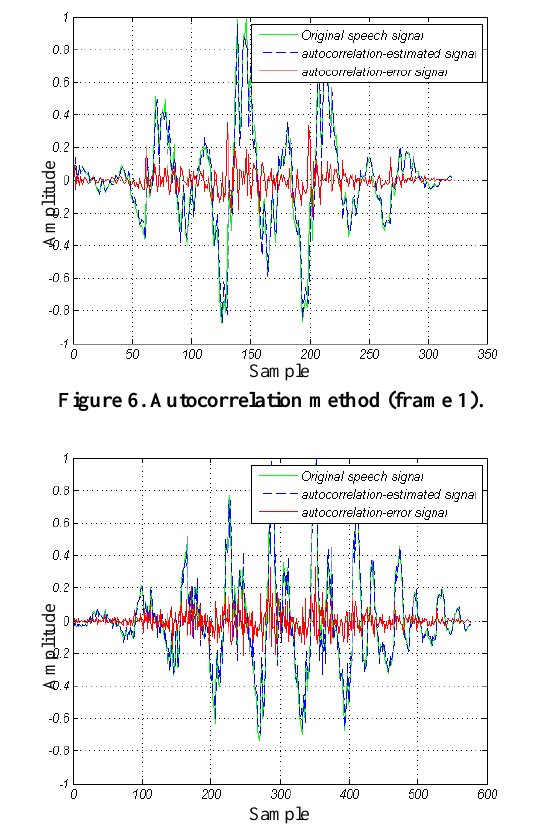
Figure 6. Autocorrelation method (frame 1).